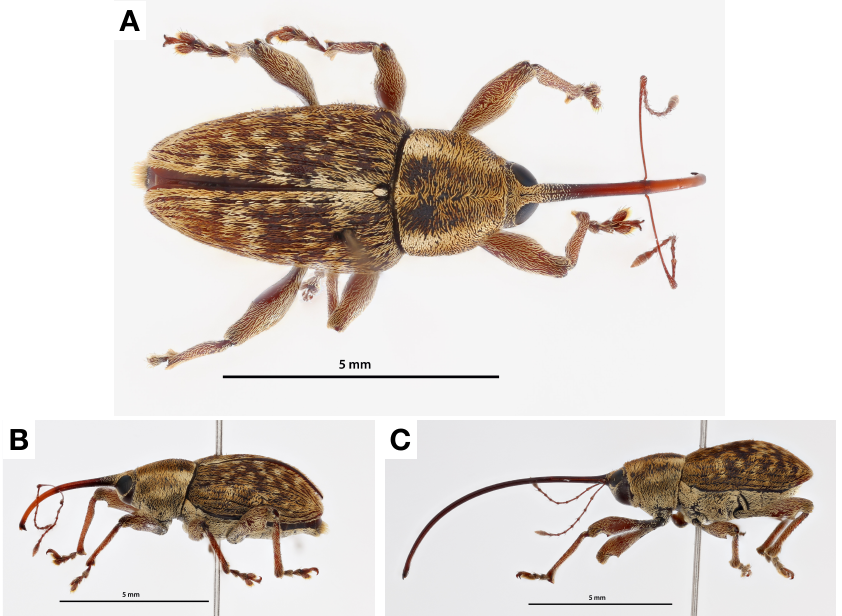
Figure 5. Adult lesser chestnut weevils ( C. sayi ). ( A ) Dorsal view of adult C. sayi male. ( B ) Side view of adult C. sayi male. ( C ) Side view of adult C. sayi female. Note difference in rostrum